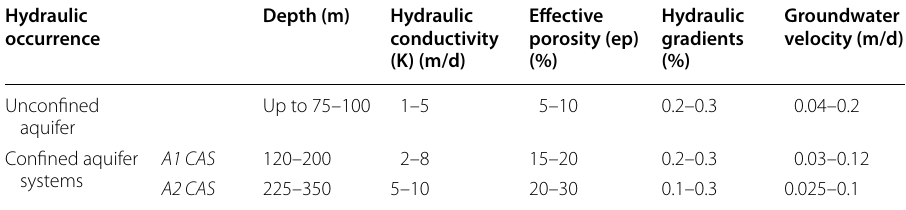
Table 1 Hydraulic features of the different aquifer